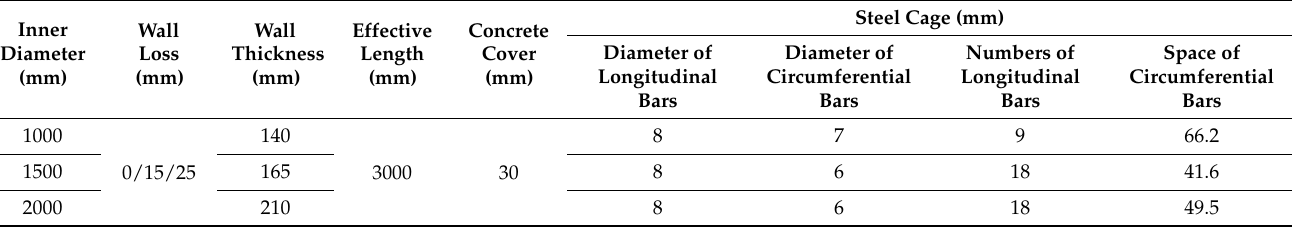
Table 1. Specifications of the reinforced concrete pipes in this study.